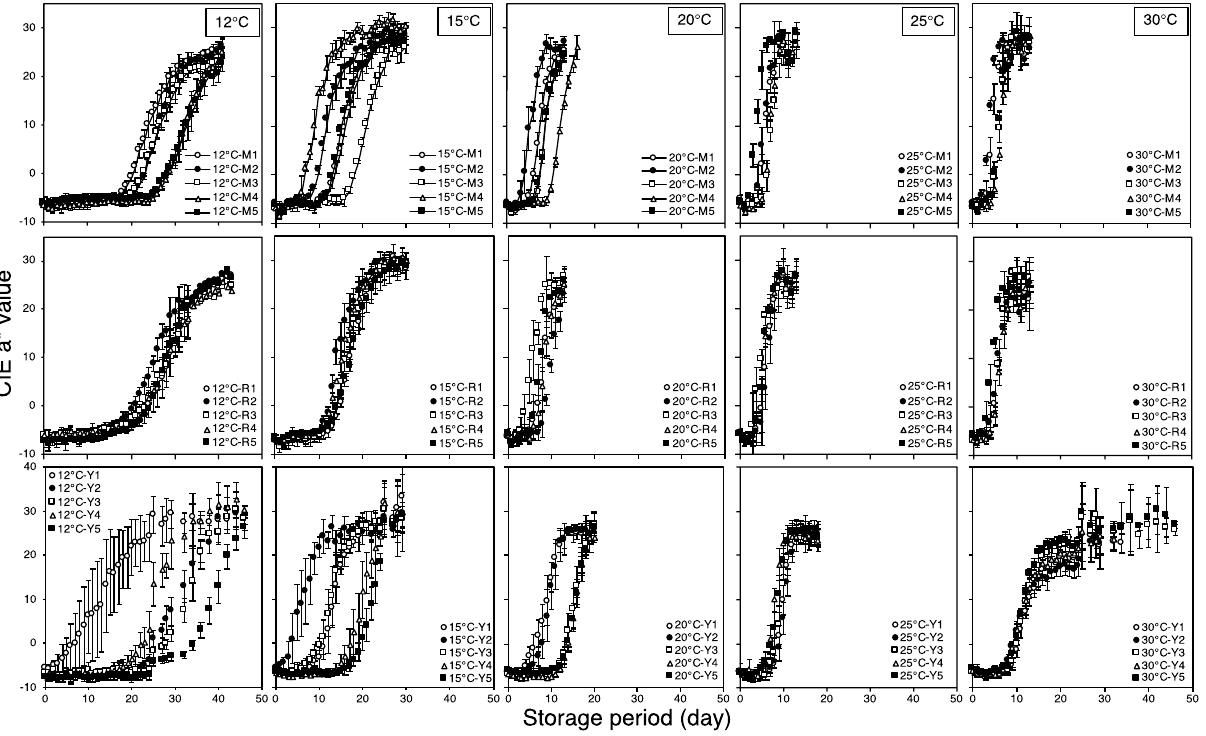
Figure 1. Change in color (CIE a* value) of tomatoes: Miracle (M), Rei-getsu (R), and Momotaro York (Y) harvested at the mature-green stage of development during the ripening at 12, 15, 20, 25, and 30